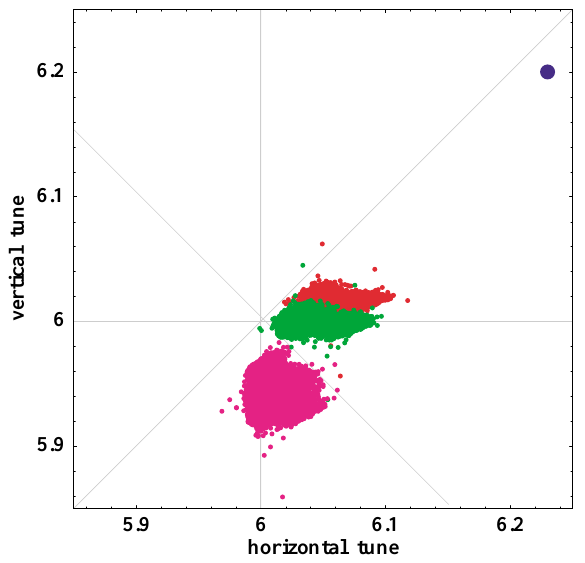
FIG. 5. (Color) Tune footprints of a KV beam for the SNS lat- tice working point (cid:3) n x , n y (cid:4) (cid:1) (cid:3) 6.23, 6.20 (cid:4) , shown by a blue dot. Intensities ˜ N (cid:1) 6.6 (red), ˜ N (cid:1) 7.3 (green), and ˜ N (cid:1) 9.7 (pink).